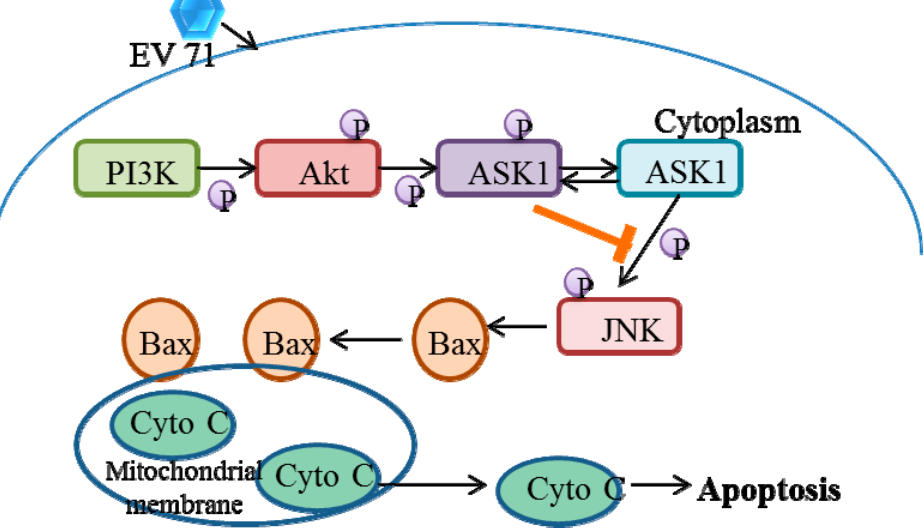
Figure 2. EV71-induced JNK-mediated apoptosis pathway inhibited by PI3K/Akt activation through phosphorylating and negatively regulating